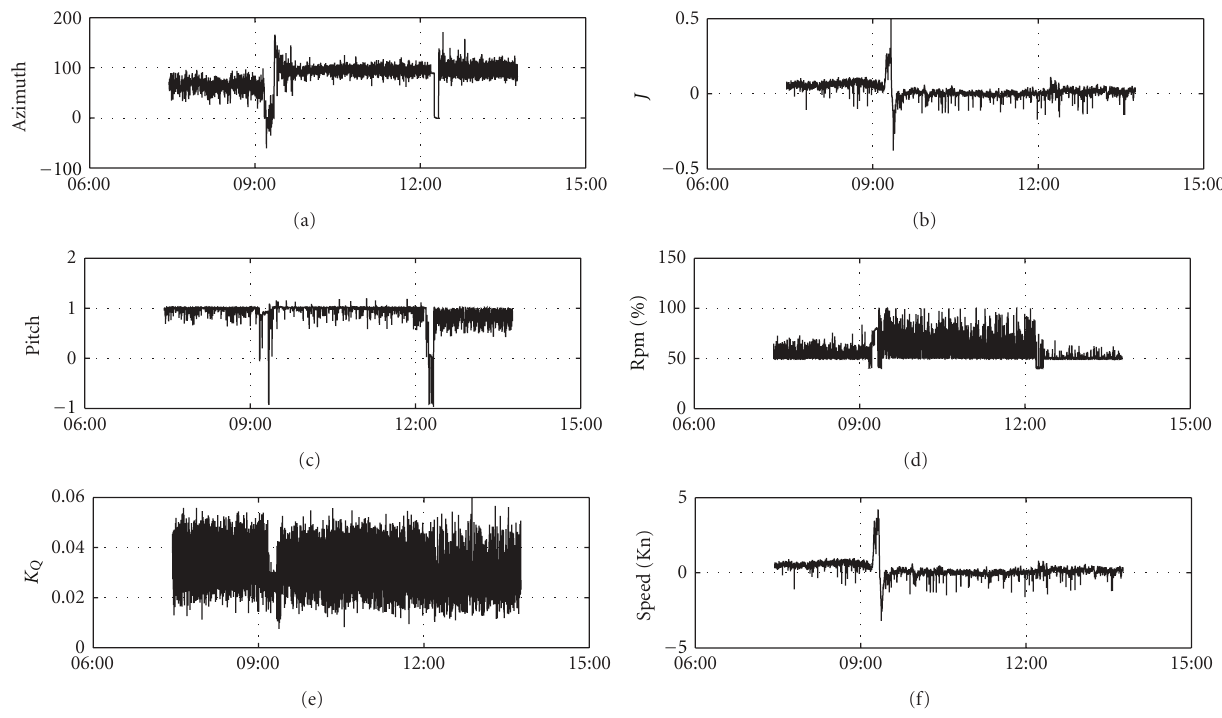
Figure 10: Time series of the propulsive system during dynamic positioning.